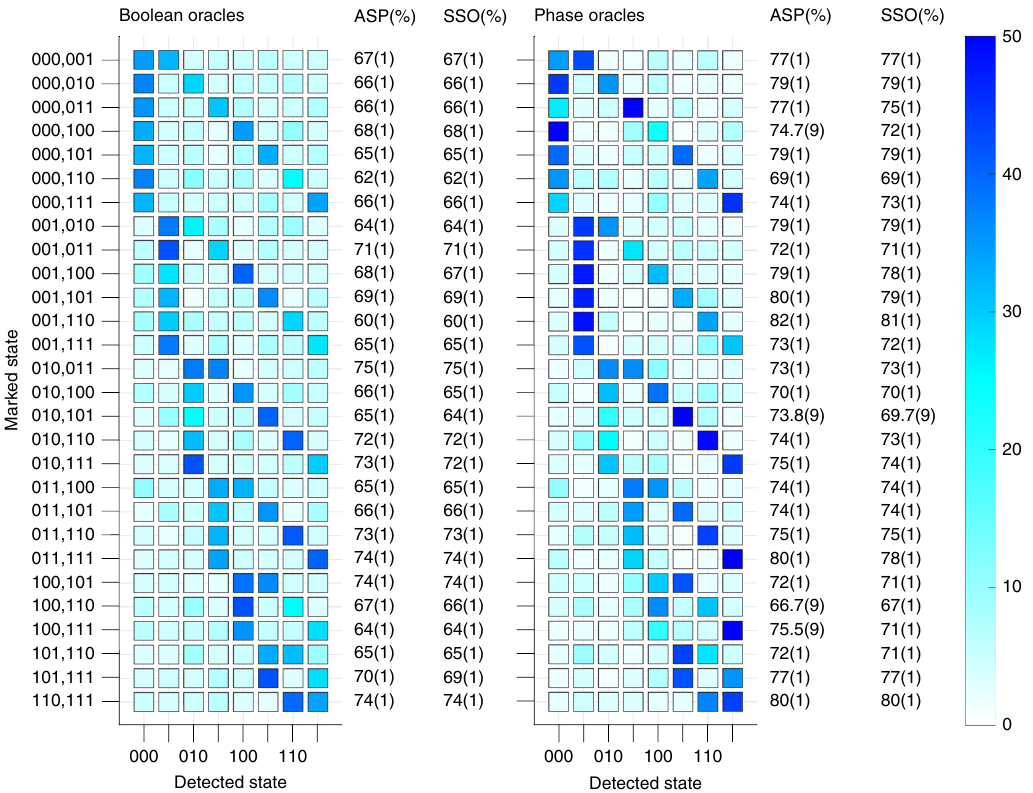
Fig. 4 Two-solution algorithm. Results from the execution of a two-solution Grover search algorithm performed on a 3-qubit database. Data for the Boolean oracle formulation are shown on the left, and data for the phase oracle formulation are shown on the right. The plots show the probability of detecting each output state. All values shown are percents. The ASP is the sum of the probabilities of detecting each of the two marked states. Data are corrected for average SPAM errors of 1%